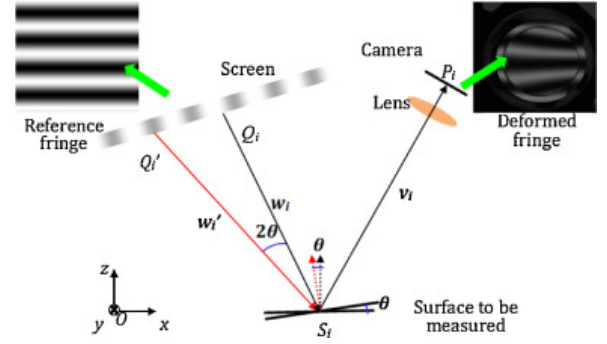
Figure 11. Deflectometry (Zhang et al., 2017)